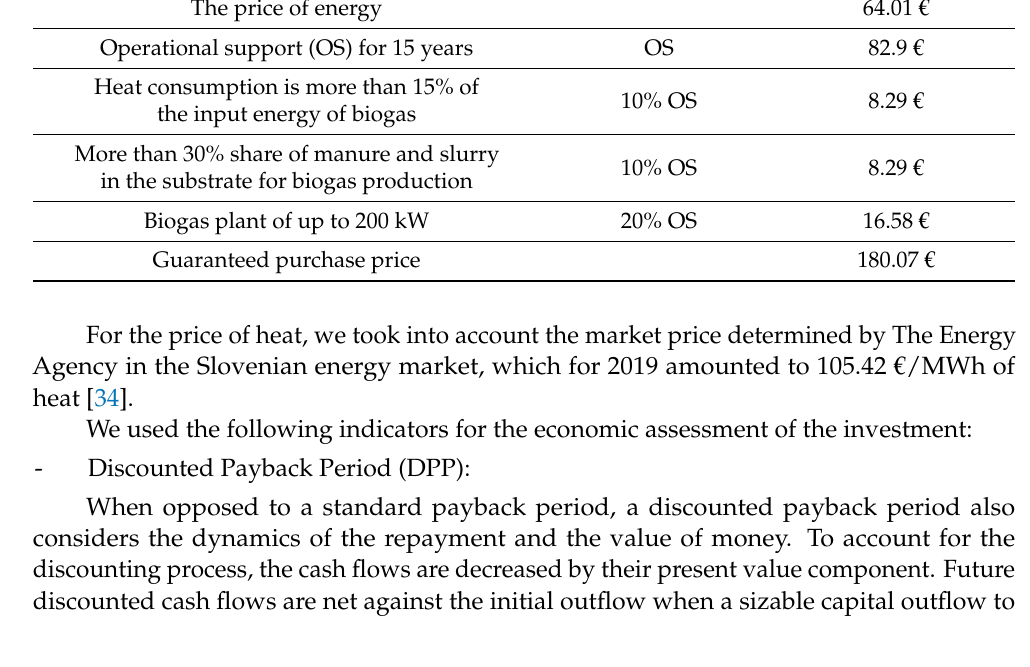
Table 2. Subsidies in EUR [34].